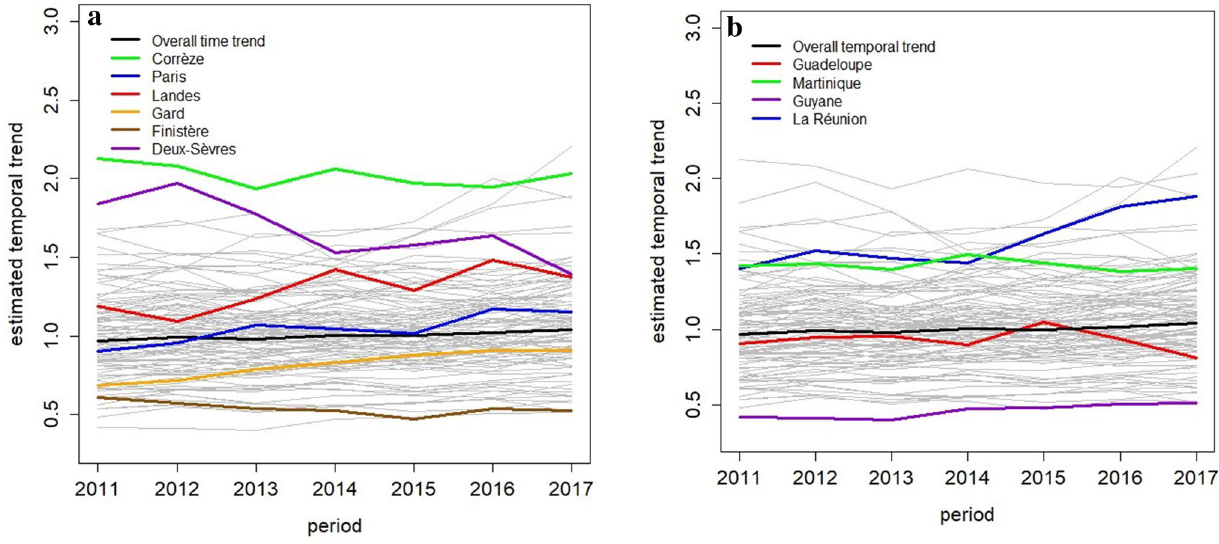
Figure 3. Estimated temporal trends (colored) for all-type cases compared to the national trend (black) ( a ) in some departments of metropolitan France and ( b ) in overseas